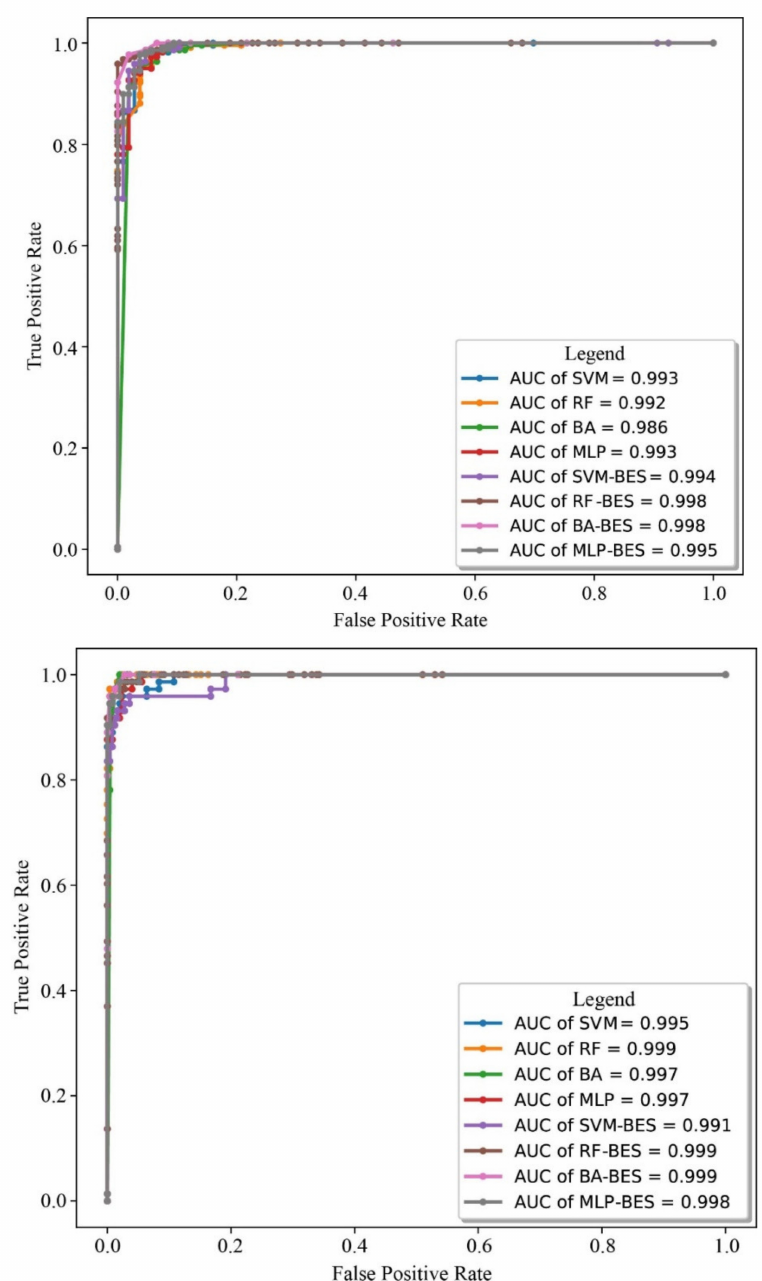
Figure 5. ROC in the model validating (top) and testing